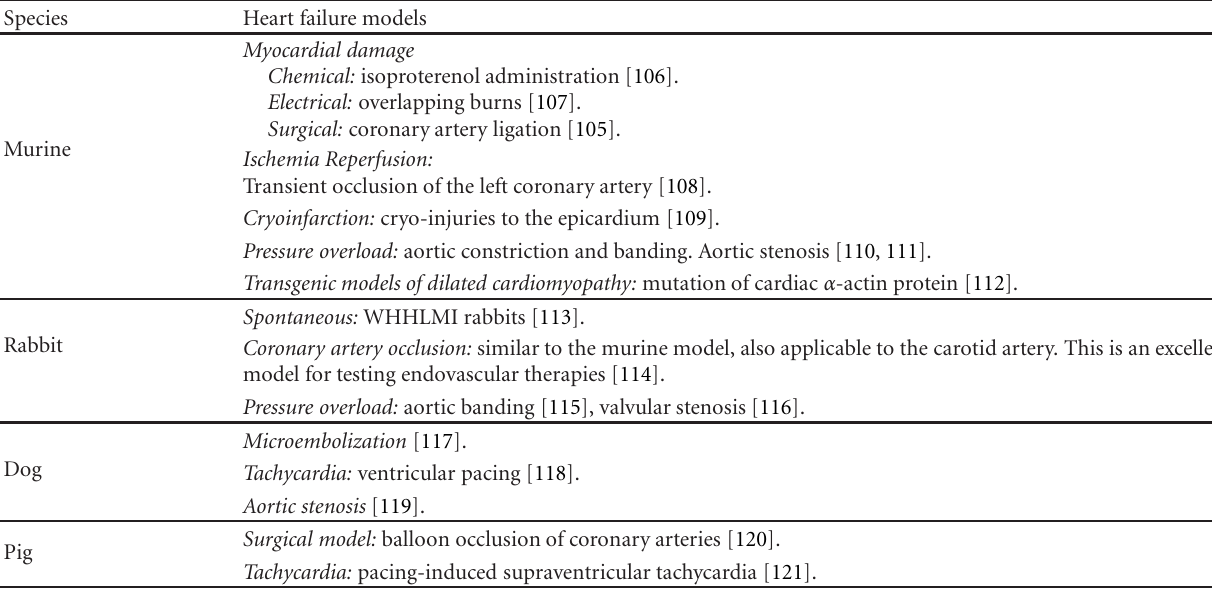
Table 4: Current procedures for inducing heart damage in